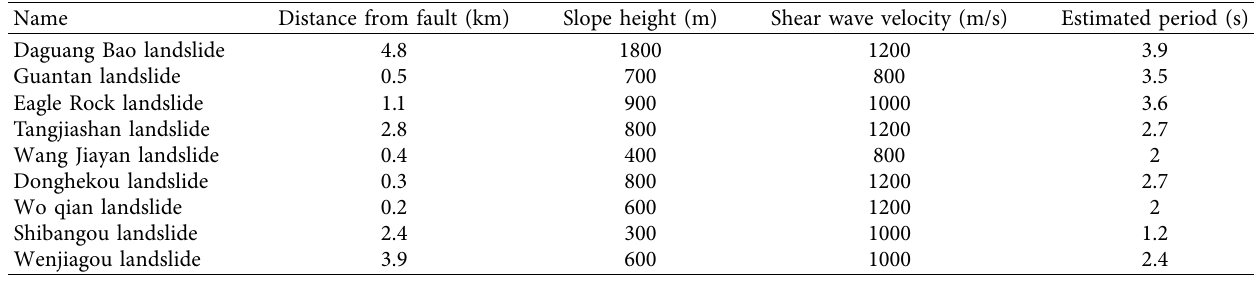
Figure 8: Variation in the period ratio T / T with shear modulus and thickness. (a) Shear modulus ratio. (b) Thickness ratio. 0 Table 1: Estimated natural period of large-scale landslides in Wenchuan earthquake.